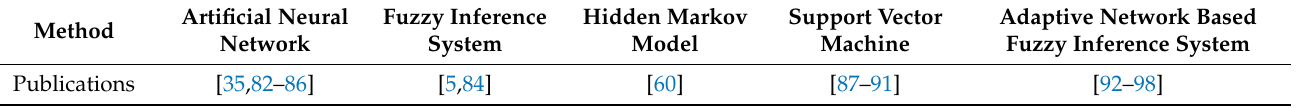
Table 2. Publications that used decision making methods in indirect tool condition monitoring system.